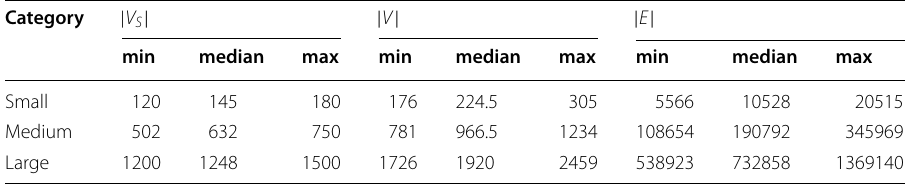
Table 3 Characteristics of instances used in